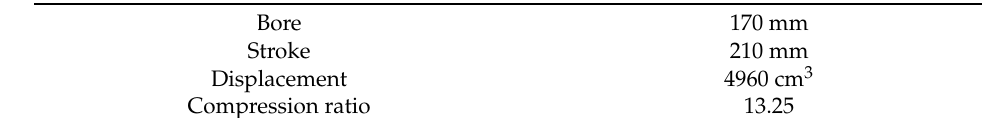
Table 1. Specifications of the research engine.